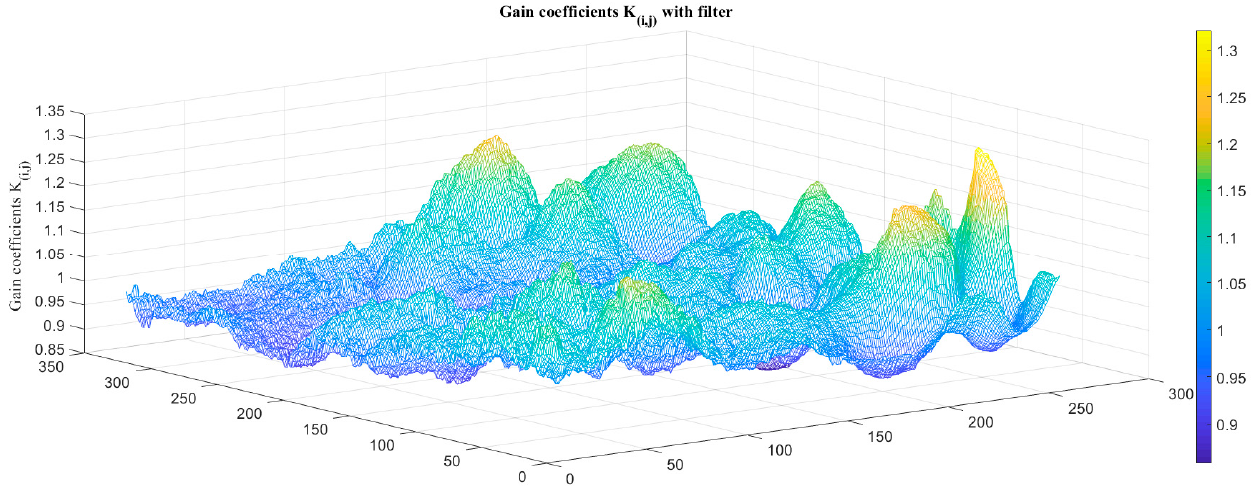
Figure 14. TPC gain coefficients K i,j with atmospheric transmittance filter.